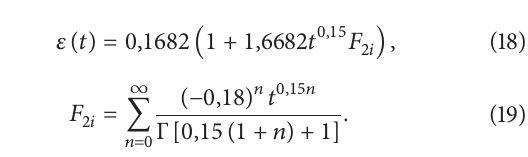
especially at short times of